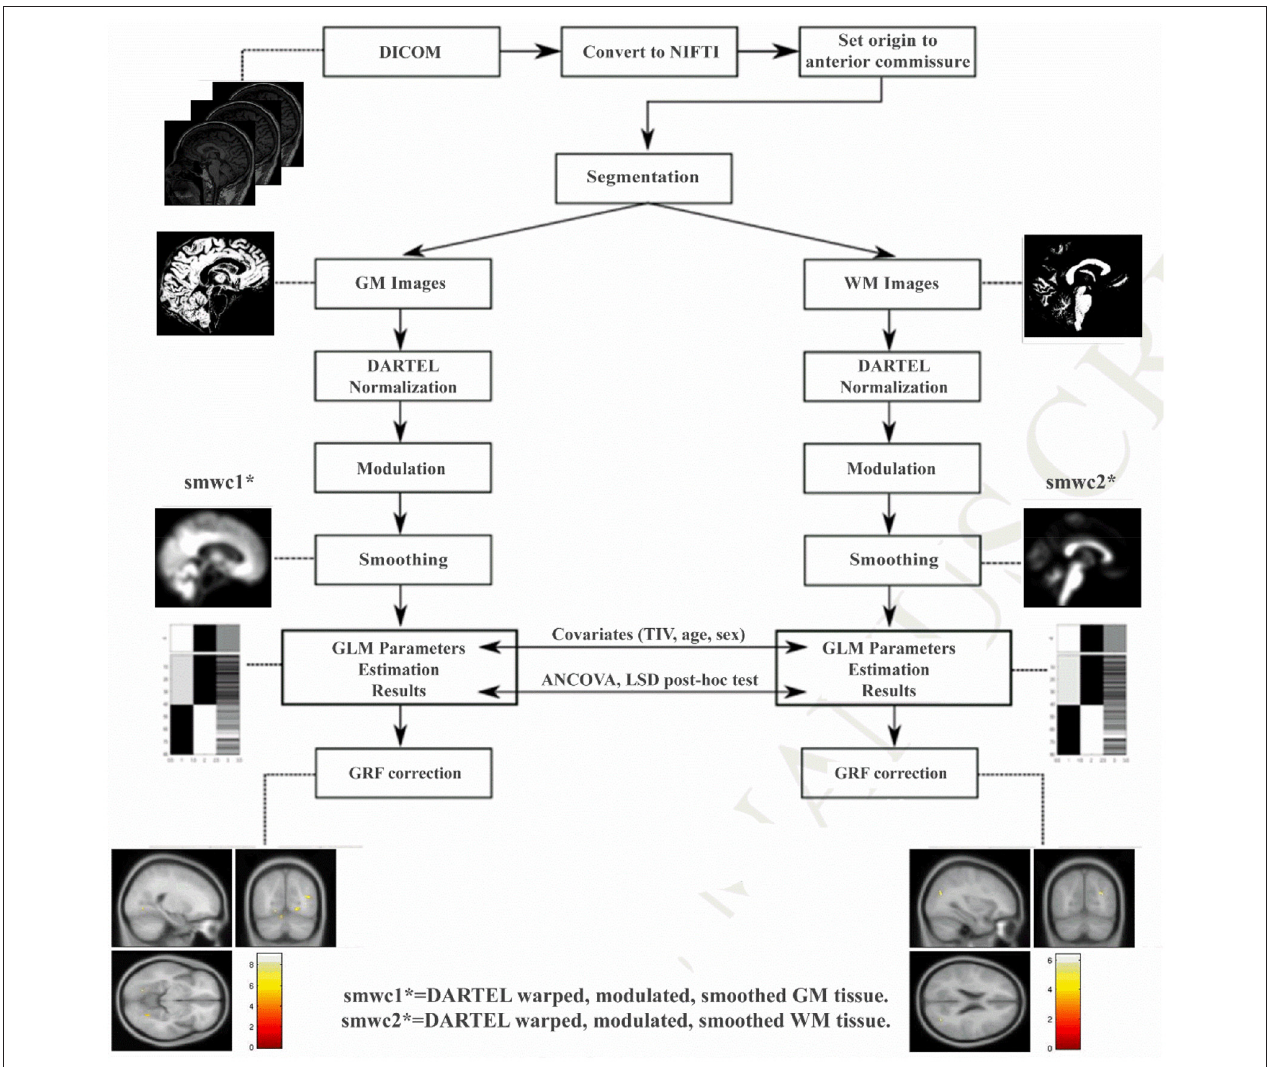
FIGURE 1 | The processing pipeline of VBM-DARTEL analysis using Statistical Parametric Mapping software. DARTEL, diffeomorphic anatomical registration through exponentiated lie algebra; GRF, Gaussian random